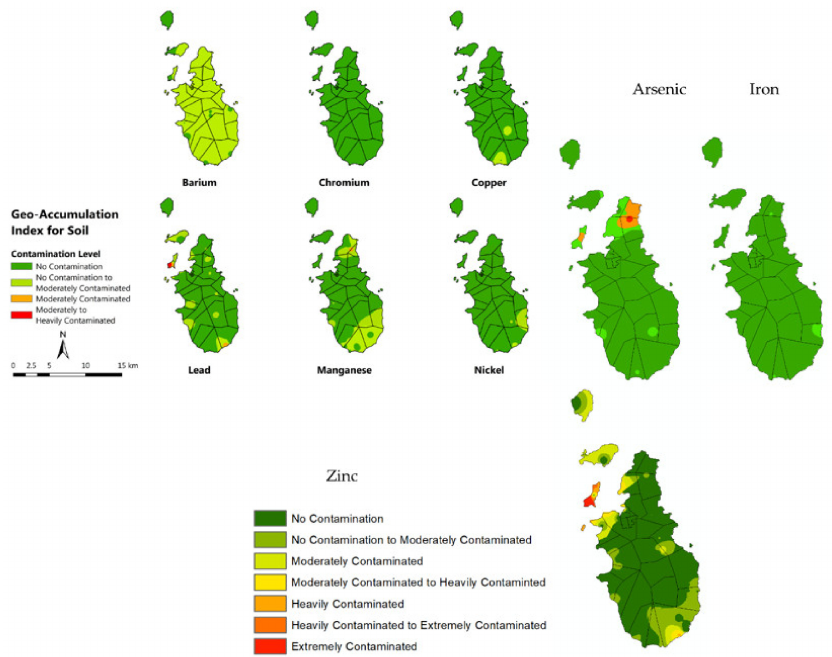
Figure 7. Geo-accumulation index of soil for Ba, Cr, Cu, Pb, Mn, Ni, As, Fe, and Zn.